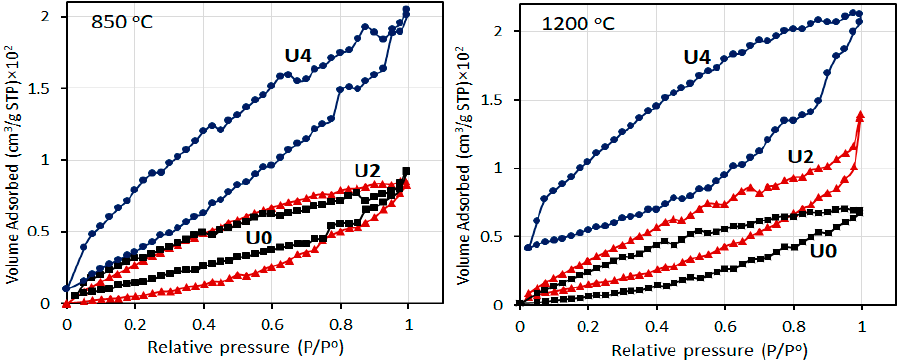
Figure 5. SEM images of the CFs carbonised at 850 °C containing 0%, 25% and 50% CTP. Average diameter (Mean ± SD) for the carbonised samples U0, U2 and U4 was 0.25 ± 0.06, 0.28 ± 0.07 and 0.57 ± 0.15 respectively.